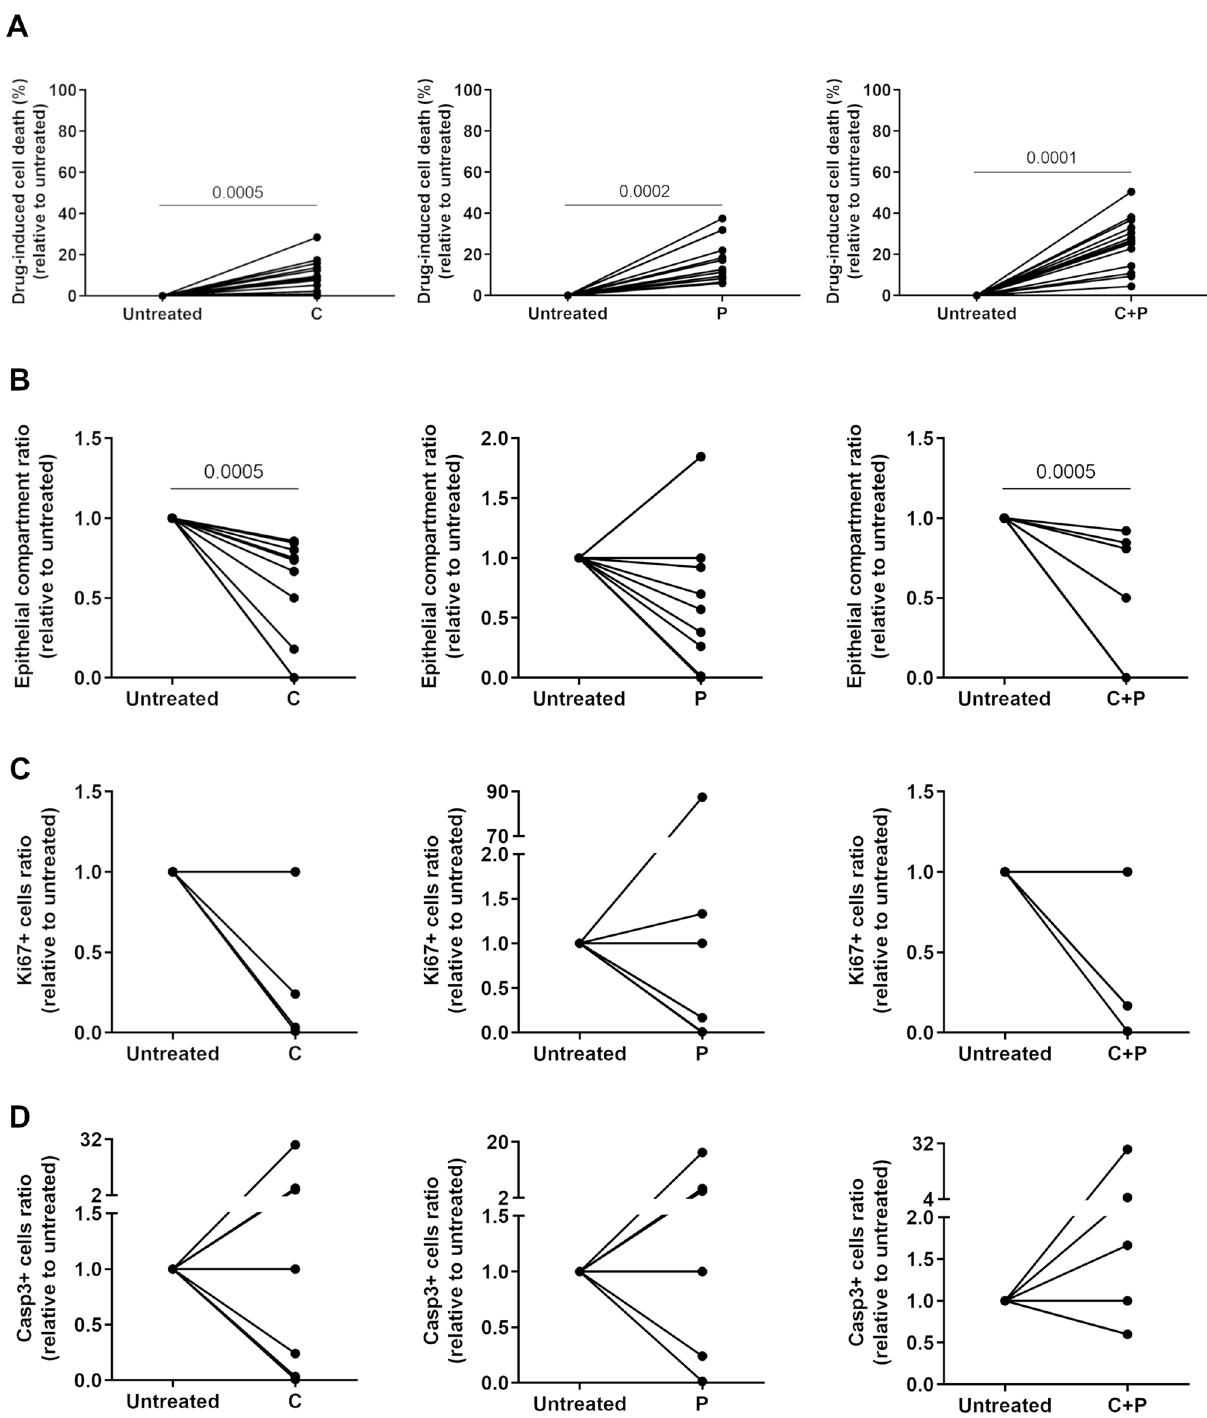
Figure 6. Drug-induced cell death variations are better captured by LDH than clinically-utilized endpoint readouts. Drug-induced cell death evaluation of OvC-PDE using ( A ) LDH assay (N = 13), ( B ) epithelial compartment (malignant tumor cells) ratio (N = 12), and ( C ) proliferation (N = 6–8) and ( D ) apoptosis (N = 6–9) levels. Wilcoxon signed-rank statistical test was applied to compare C + P with untreated condition for all readout methods (for statistically significant differences, p -values are indicated in the graphics, C: carboplatin; P: